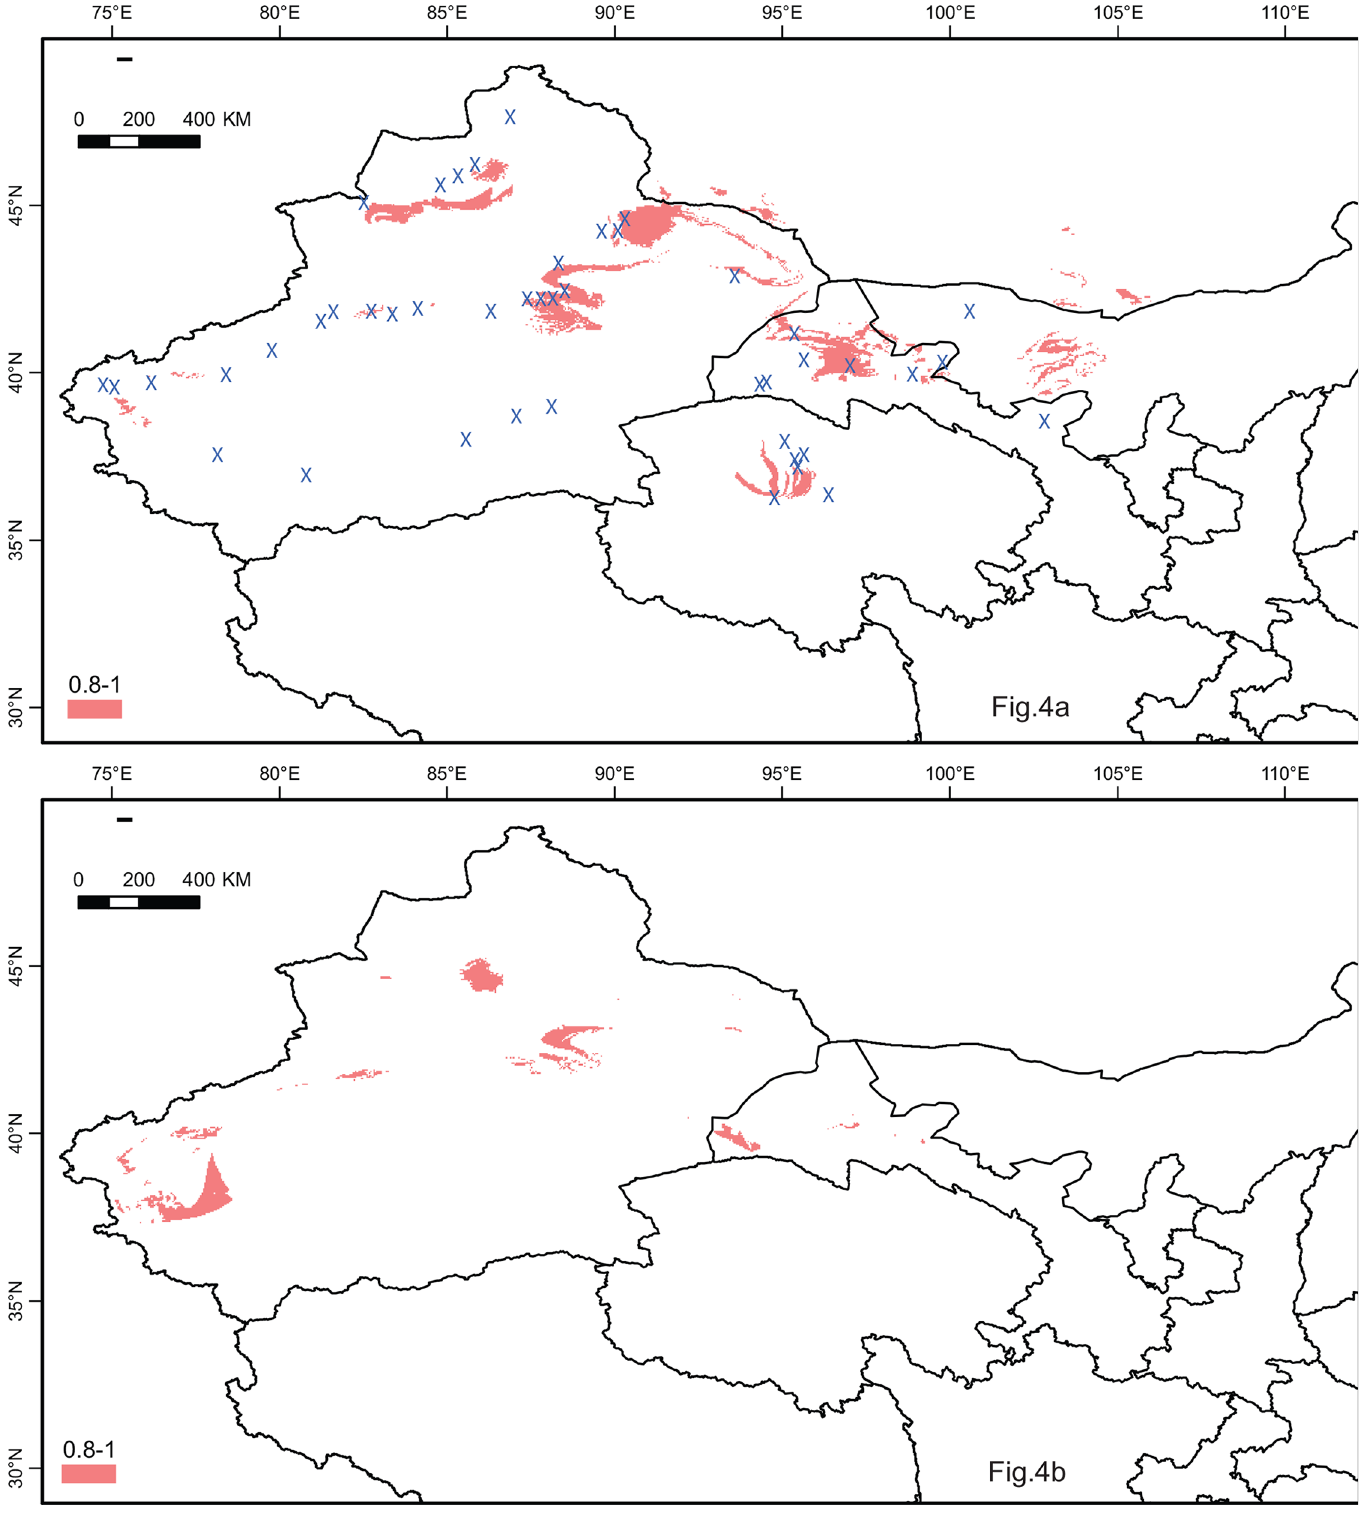
Fig 4. Maps depicting potential distribution as occurrence probability of Ephedra przewalskii in the northwestern China during (a) present-day and (b) LGM based on the CCSM models as derived from the ecological niche models (ENMs) in MAXENT.